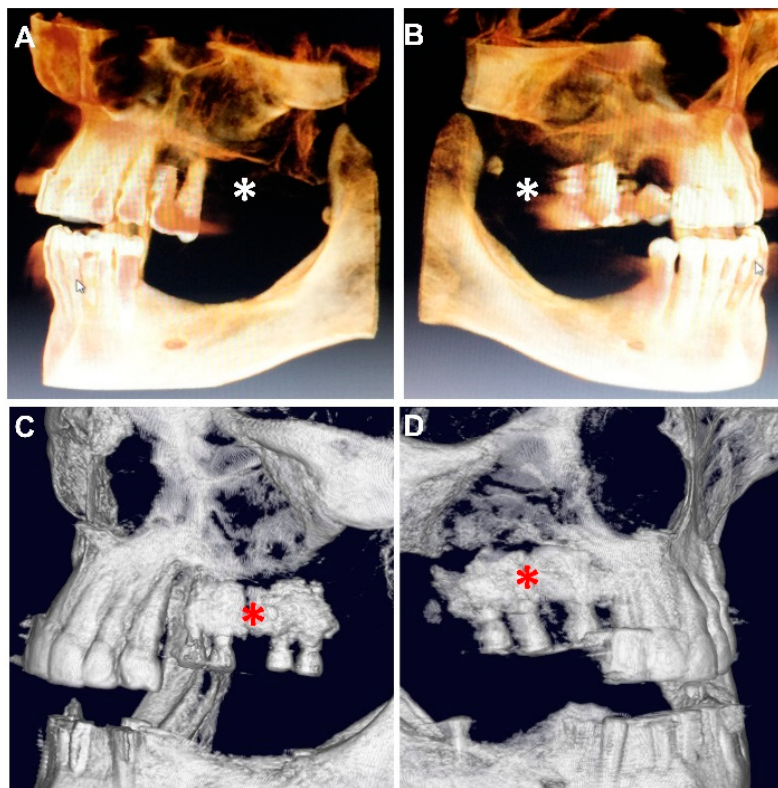
Figure 5. Bone loss and Paste-CPC-filled defect were visualized using 3D reconstruction resulting from CBCT imaging. The large defect area (white asterisks) resulting from significant loss is of the buccal bone on both sides. Bone substitute material surrounds the new implants after injection (red asterisks) using the window approach ( A , C : left side, B , D : right side).